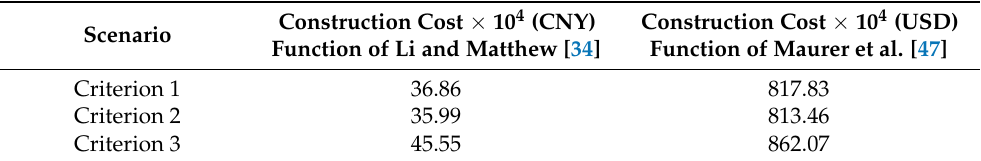
Table 5. Construction cost for each criterion in the benchmark proposed by Moeini and Afshar [46].